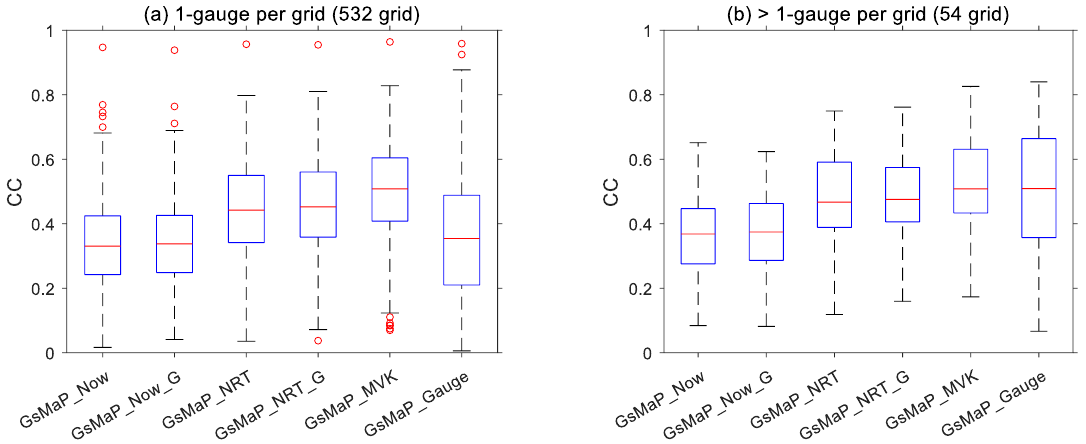
Figure 14. Boxplot of CC for daily data of grid with one ( a ) and more than one rain gauge ( b ) in the GSMaP grid.